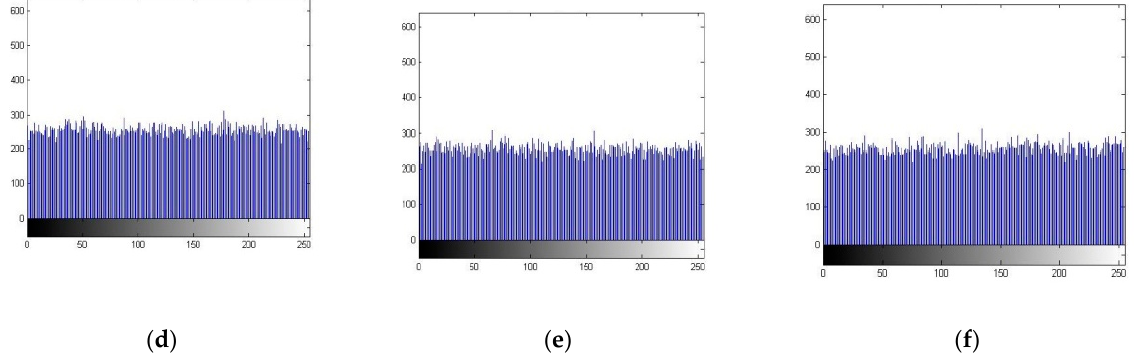
Figure 5. Histogram analysis of Lena (256 × 256 × 3). ( a – c ) shows the histogram of plain RGB channels and ( d – f ) shows the histogram of encrypted RGB channels.